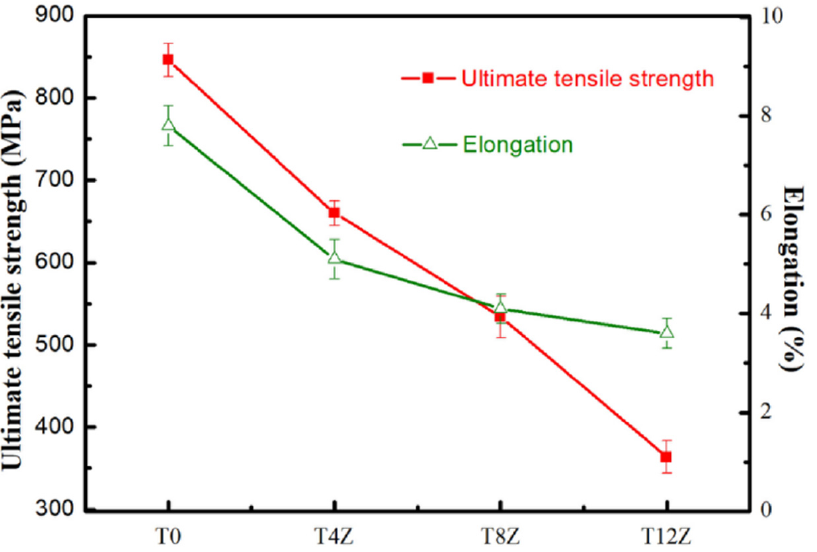
Figure 12. The ultimate tensile strength and elongation of Ti-30Mo-0.5TiC-xZr alloys at room tem-